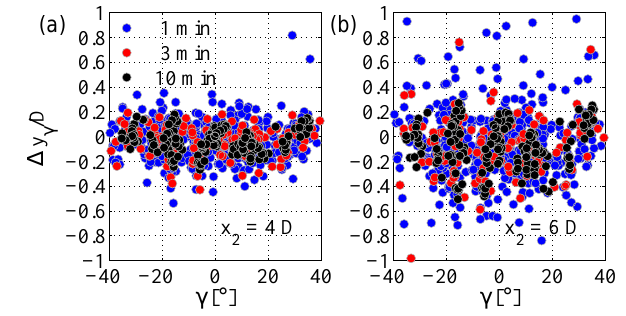
Figure 13. Same as in Fig. 8 but for the CBL simulation and for a time series of 60min.